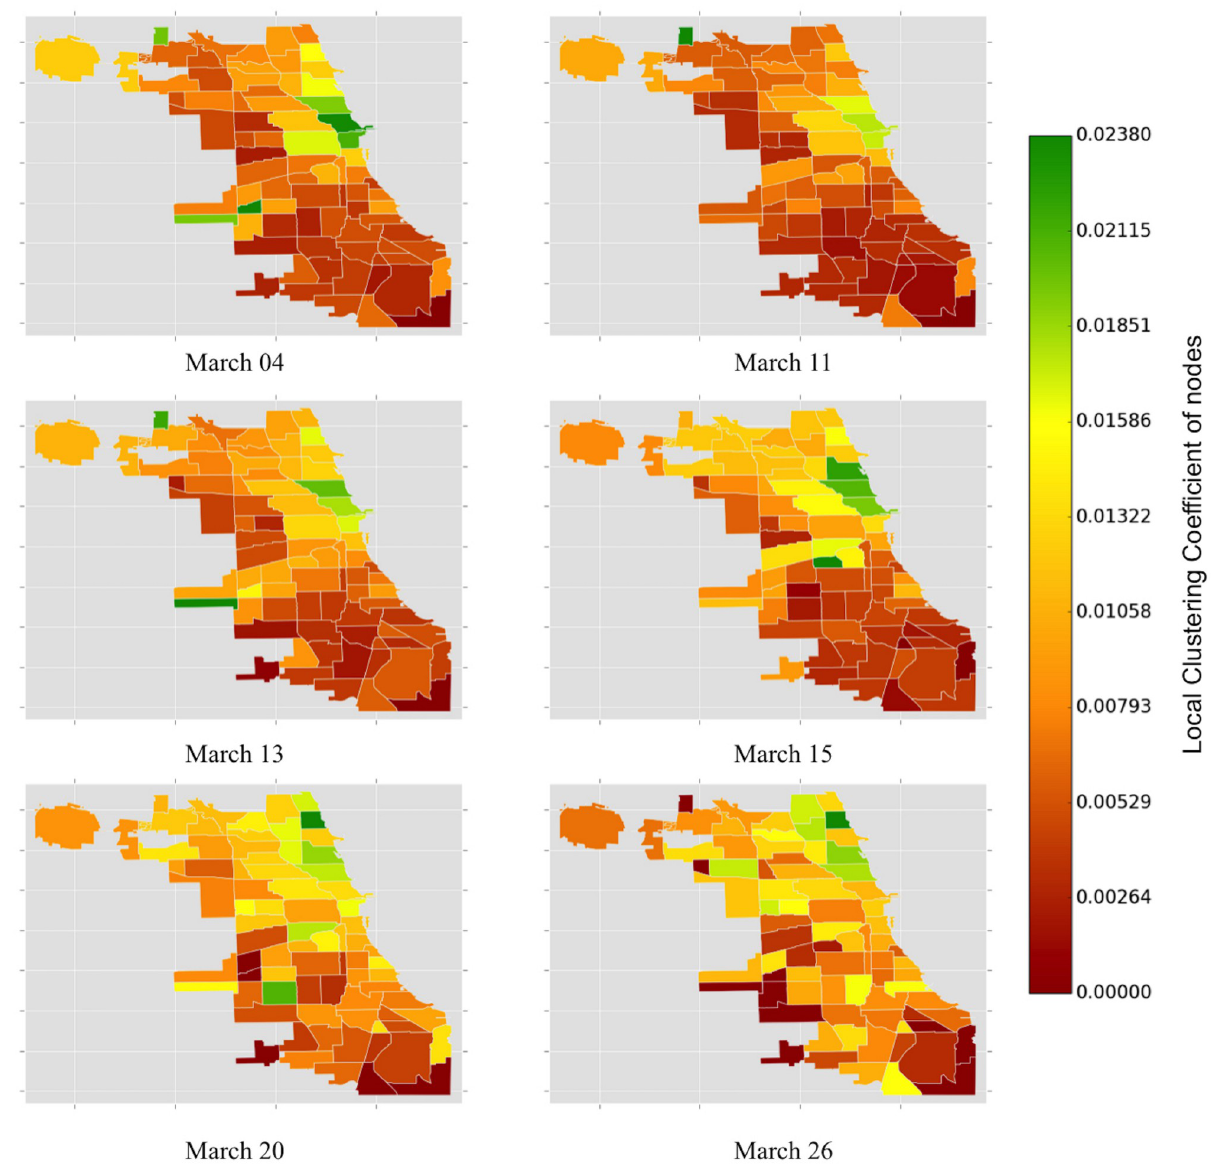
Fig 9. The color of the Chicago community areas is proportional to the weighted local clustering coefficient of the nodes (community areas). The heat map of the weighted local clustering coefficient complements the observation in Fig 4. The color spectrum of the taxi zones appears to be shifting towards green during the onset of the